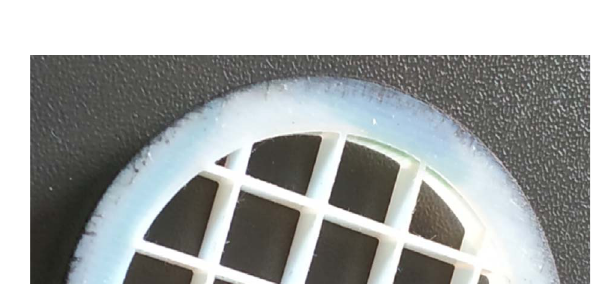
CL stands for characteristic length.